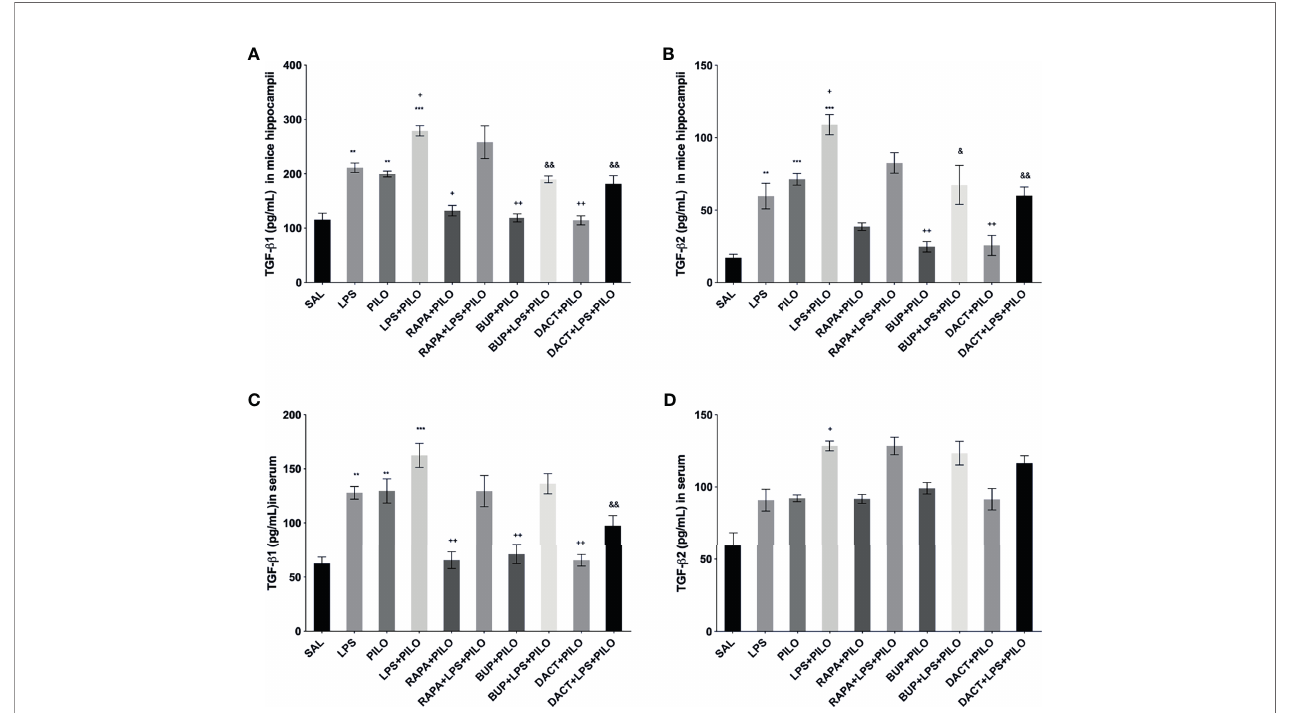
FIGURE 10 | Effects of RAPA, BUP, and DACT on TGF- b signaling in LPS/PILO-treated C57BL/6 mice. The cytokine levels (pg/ml) in the above fi gure were measured hippocampal and serum samples of C57BL/6 mice. The fi gure is represented as effects on the levels of TGF- b 1 in (A) hippocampal and (B) serum samples. Effects on the levels of TGF- b 2 in (c) hippocampal and (d) serum samples. The data are represented as mean ± SEM (n=3) and analyzed by one-way ANOVA followed by Tukey Kramer multiple comparison tests. The signi fi cance is ascertained as ***p < 0.001 versus SAL, **p<0.01 versus SAL, && p<0.001 versus LPS+PILO, & p<0.05 versus LPS+PILO, ++ p<0.01 versus PILO, and + p<0.05 versus